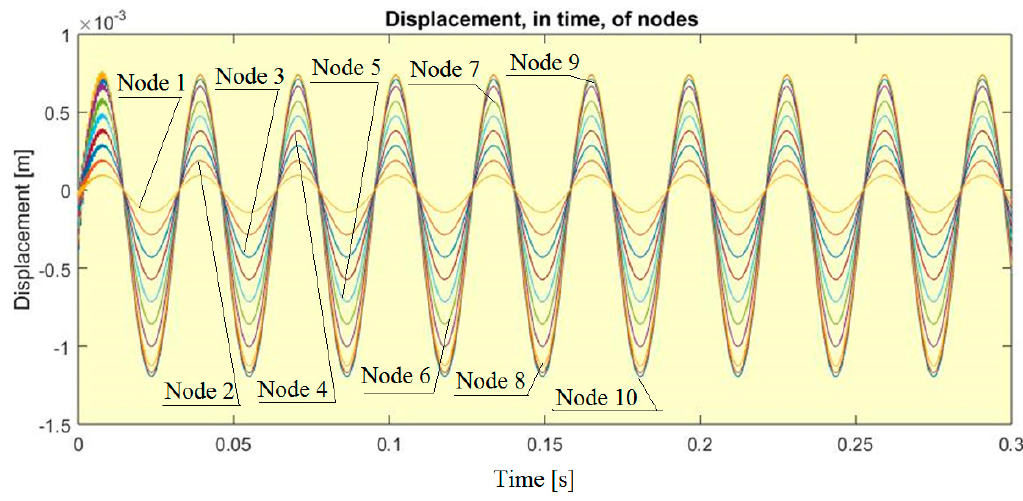
Figure 4. Displacements of all nodes, with damping.